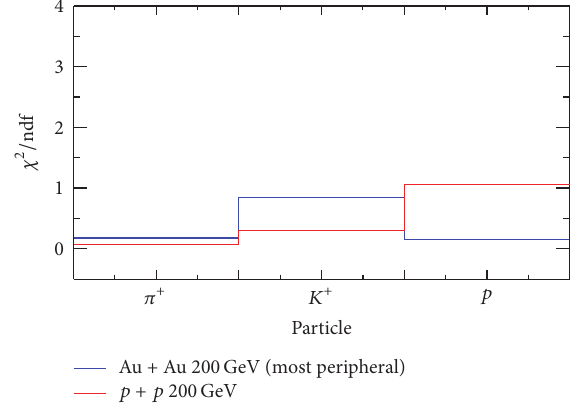
Figure 1: 𝜒 2 / ndf values are shown for most peripheral Au + Au and 𝑝 + 𝑝 collisions at √𝑠 NN = 200 GeV using (7) as a fit